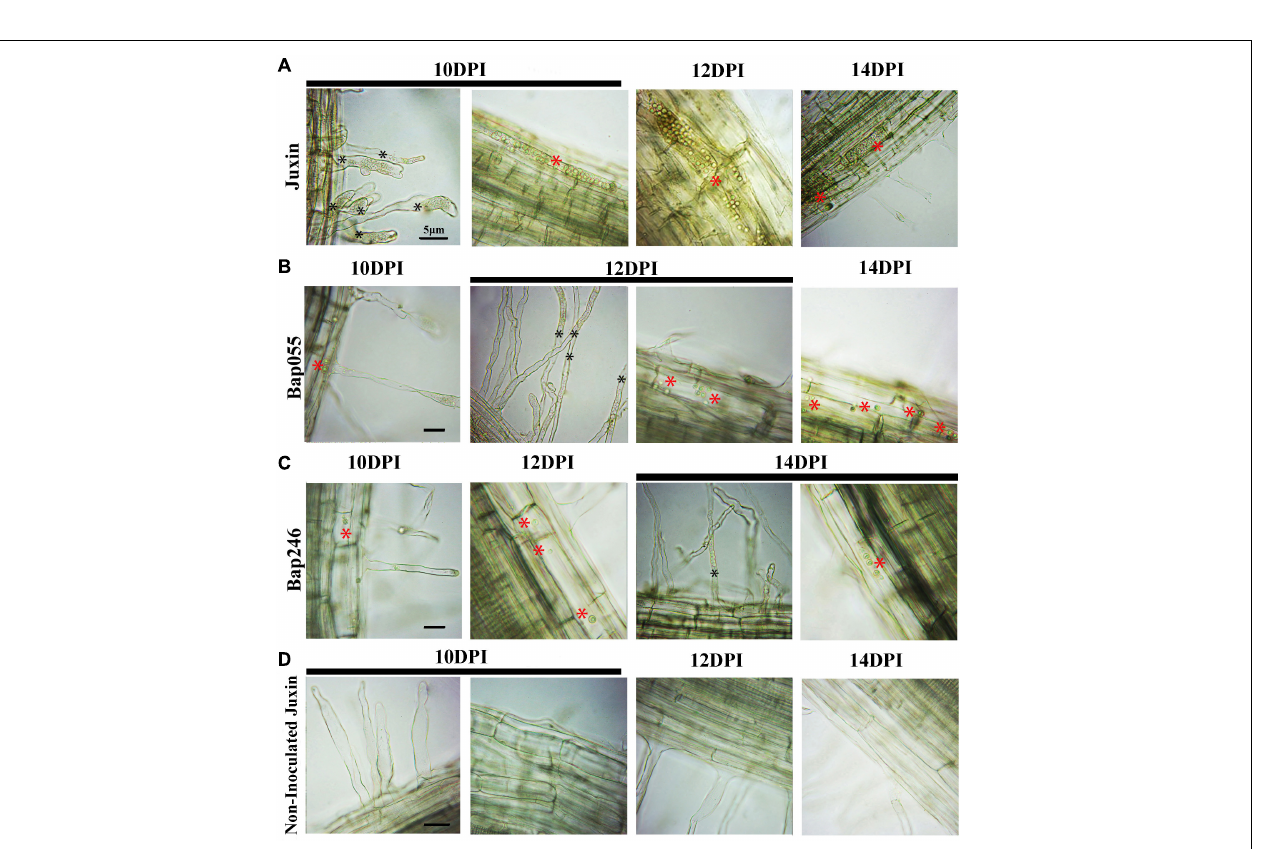
FIGURE 5 | Secondary infection of different Chinese cabbage genotypes by P. brassicae at 10–14 days post-inoculation (DPI). (A) Inverted microscopy images of cortical cells of the genotype “Juxin” at 10–14 DPI. (B) Inverted microscopy images of cortical cells of the genotypes Bap055 at 10–14 DPI. (C) Inverted microscopy images of cortical cells of the genotype Bap246 at 10–14 DPI. (D) Inverted microscopy images of cortical cells of non-infected “Juxin”. Secondary plasmodium of host cortical cells was indicated with red ∗ , Zoosporangia of root hair were indicated with black ∗ .